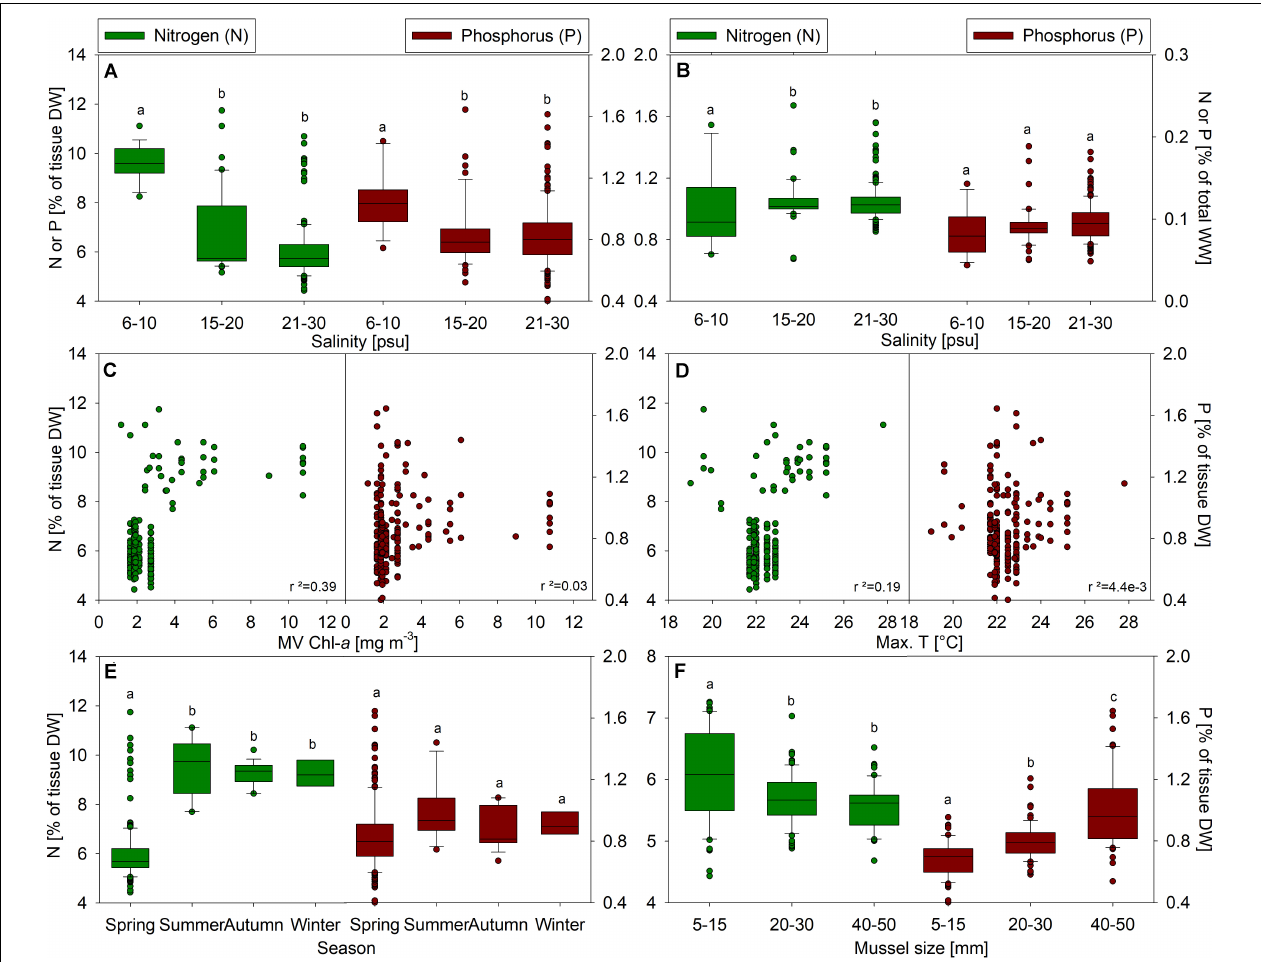
FIGURE 3 | Nitrogen (N, green, on the left) and phosphorus (P, red, on the right) content in tissue dry weight (DW) and total wet weight (WW) plotted over different environmental parameters: (A) salinity categories (DW), (B) salinity categories (WW), (C) mean value chlorophyll- a (DW) and (D) maximal water temperatures (DW); as well as nutrients over (E) season of harvest and (F) mussel size (in shell length, only Swedish